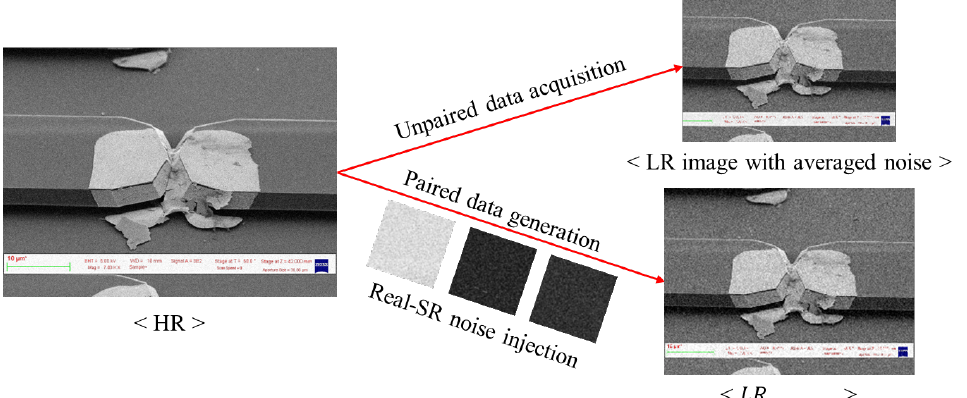
Figure 4. Data formulation: paired image generation from unpaired HR–LR dataset for supervised SR training.